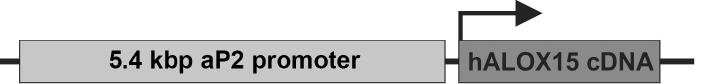
Figure 1. Schematic structure of the ALOX15 transgene used for the creation of aP2-ALOX15 trans- genic mice. The transgene construct was microinjected into fertilized eggs of C57BL/6 mice, and heterozygous transgenic allele carriers were used to establish a colony of homozygous aP2-ALOX15 mice.